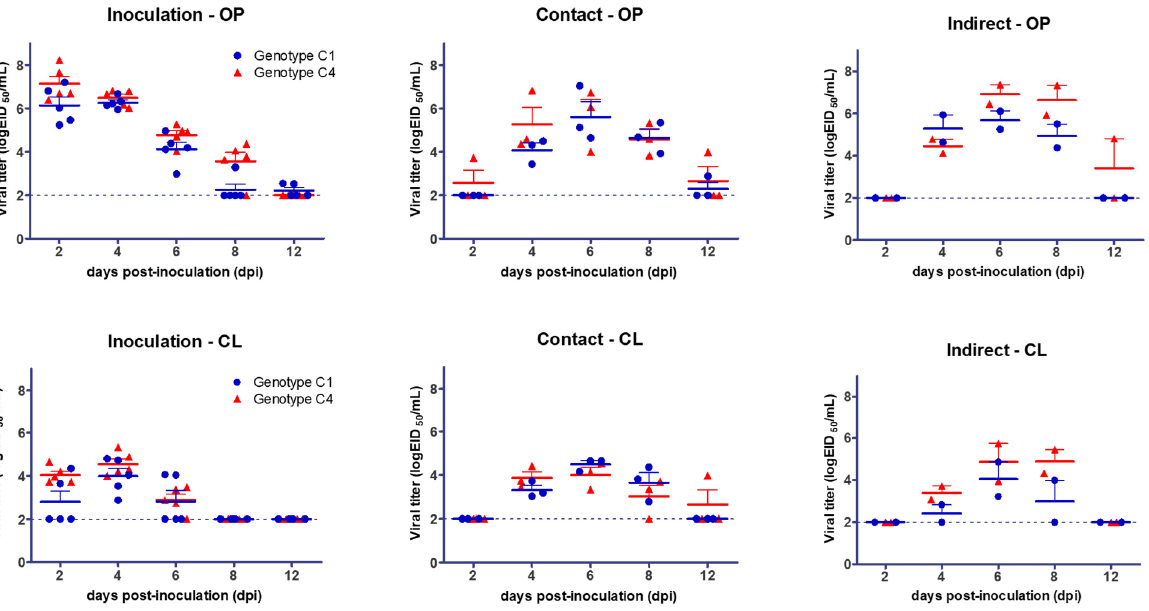
Figure 1. Viral shedding of mandarin ducks infected with genotypes C1 and C4 of clade 2.3.4.4 H5N6 HPAIV. The detection limit was 10 2 EID 50 equivalent/mL (dotted line). OP, oropharynx; CL, cloaca; blue dot, genotype C1; red triangle, genotype C4.